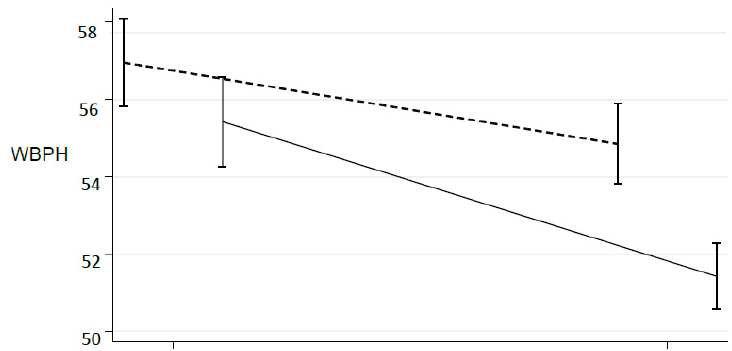
Figure 5. Percentage of WB during rehabilitation program about the healthy limb. CG: dot line; EG: solid line.